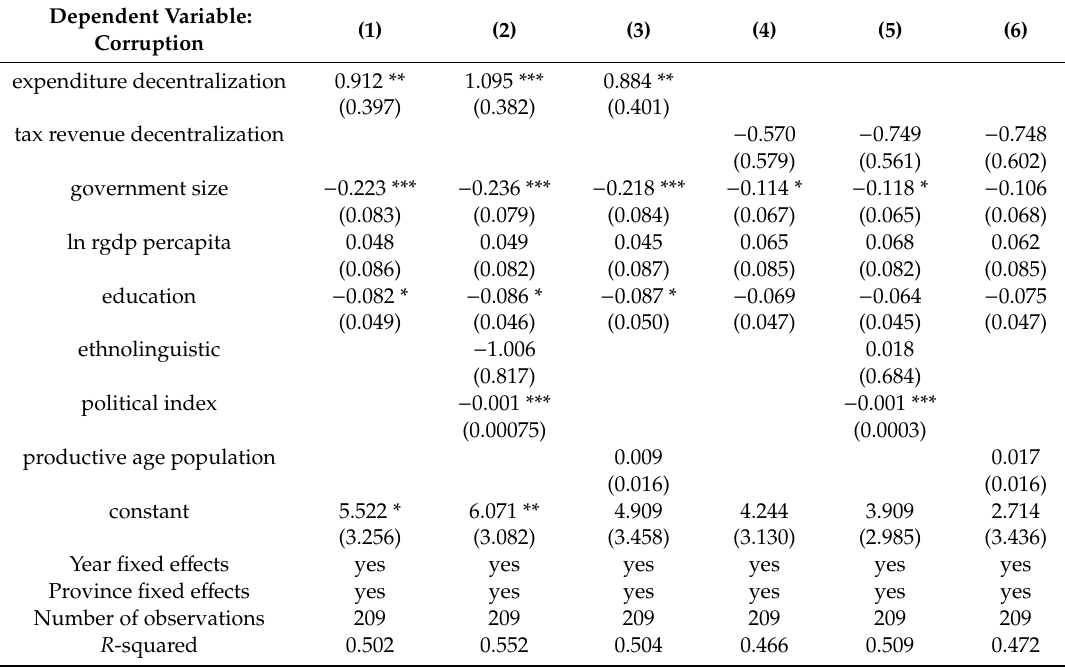
Table 3. Random E ff ects